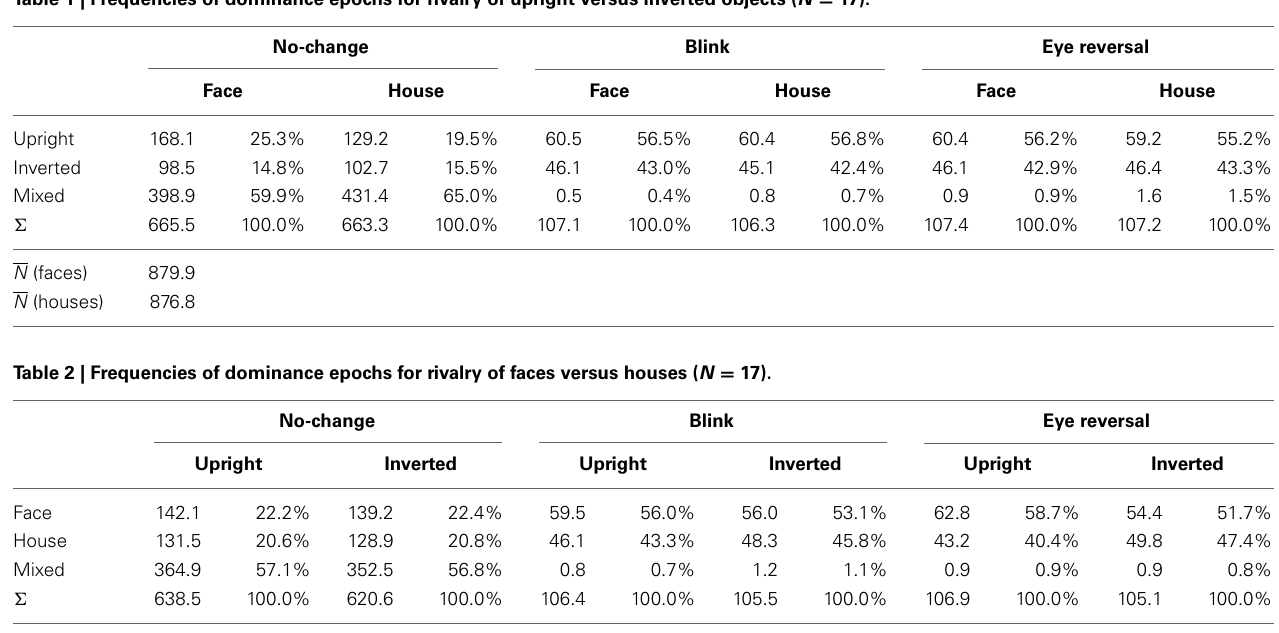
Table 1 | Frequencies of dominance epochs for rivalry of upright versus inverted objects ( N = 17).